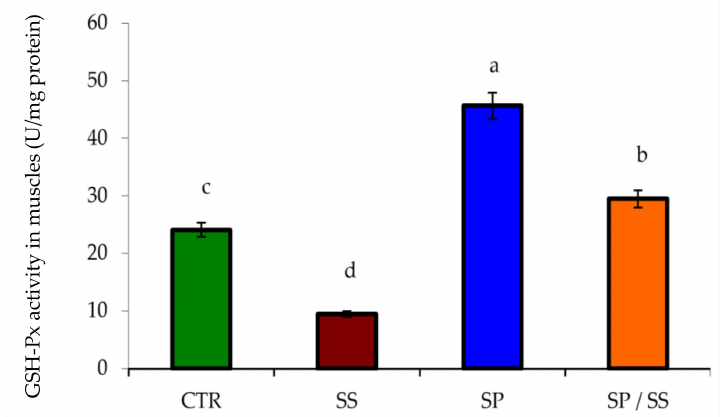
Figure 2. Glutathione peroxidase (GSH-Px) levels in muscle tissues of Nile tilapia after sodium sulphate (SS) exposure and fed diets with or without S. platensis (SP) for 8 weeks. Values are expressed as mean ± standard errors (SE) ( n = 3). a,b,c,d = letters on top of the bars show that the groups are significantly di ff erent from those in the control group (CTR) ( p <